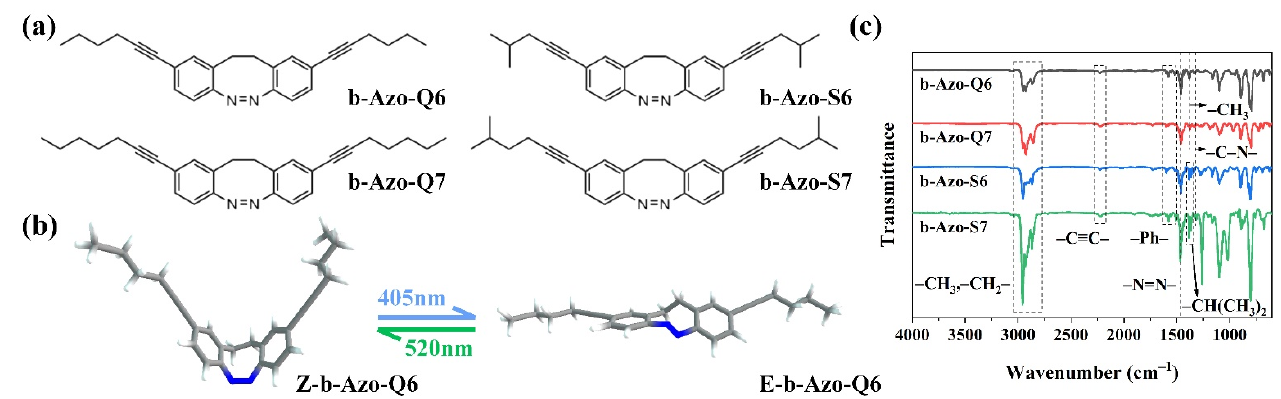
Figure 1. ( a ) Chemical structures of the four b-Azo chromophores; ( b ) Z-E isomers of b-Azo-Q6; ( c ) FTIR spectra of four b-Azo chromophores.